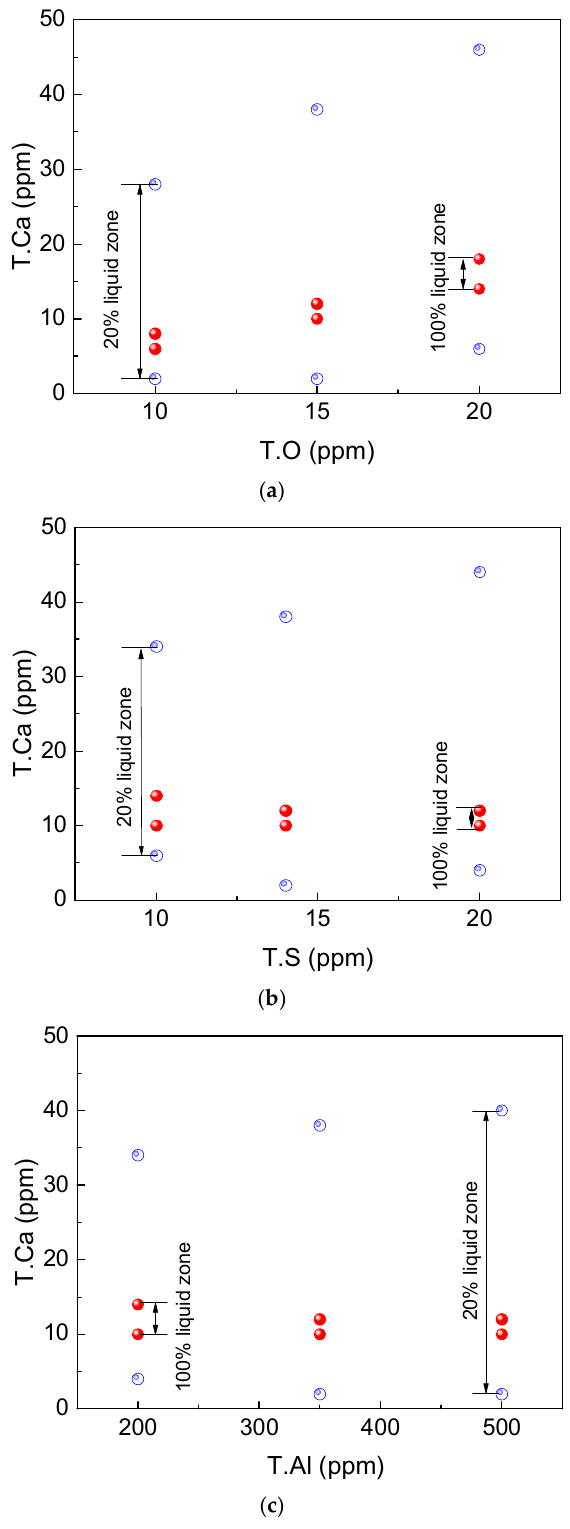
Figure 13. Effect of T.O, T.S, and T.Al on the liquid zone of inclusions for Ca treatment. ( a ) T.O, ( b ) T.S, ( c )T.Al